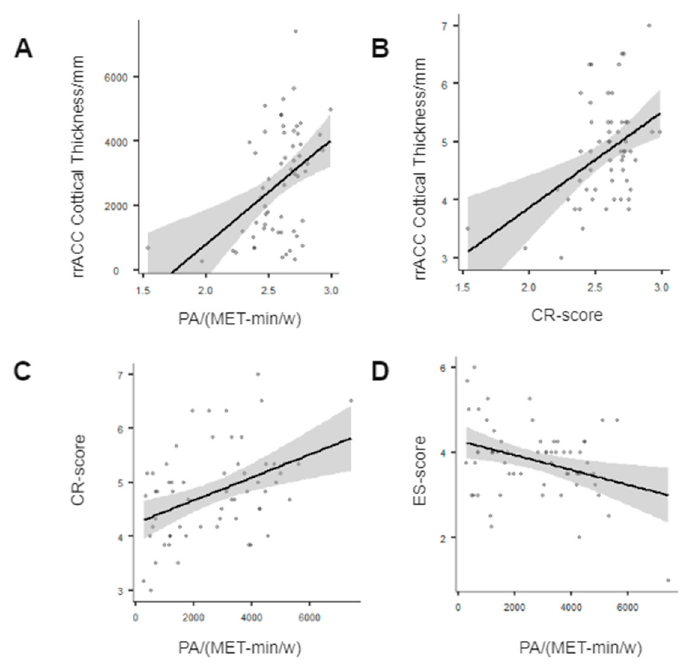
Figure 3. ( A ) PA levels were positively correlated with rrACC; ( B ) rrACC was positively correlated with CR; ( C ) PA levels were positively correlated with CR; ( D ) PA levels were negatively correlated with ES. Abbreviations: PA, physical activity; rACC, rostral anterior cingulate cortex; CR, cognitive reappraisal; ES, expressive